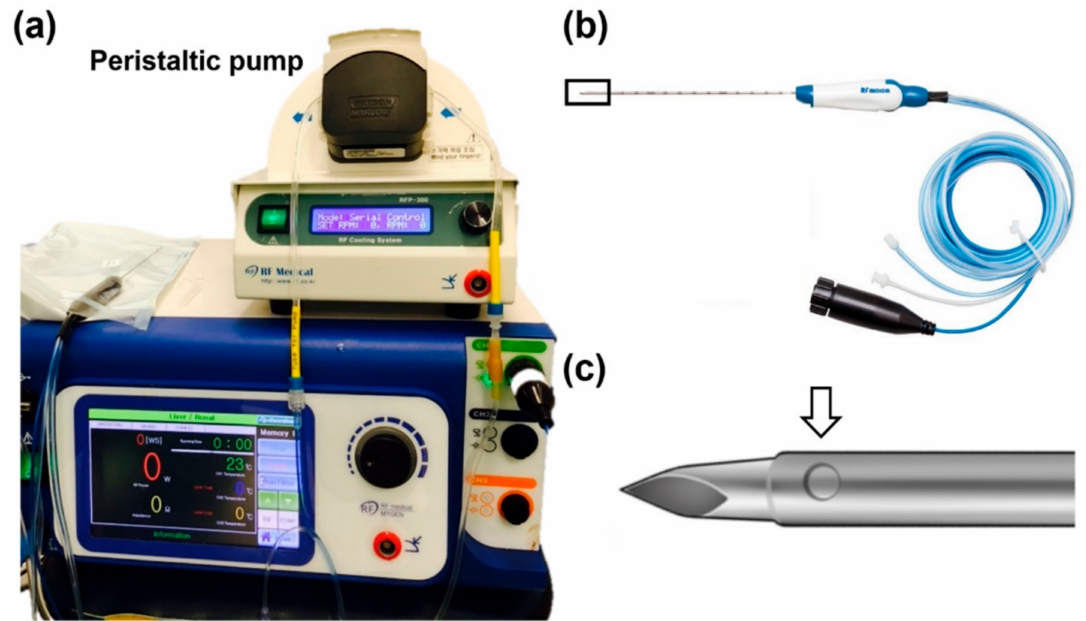
Figure 2. The radiofrequency ablation (RFA) system configuration. ( a ) A three-channel radiofrequency ablation system, which can allow the use of multiple electrodes in either monopolar or bipolar modes. ( b ) An internally cooled wet electrode with a 2-cm active tip. ( c ) The magnified image of the DRCWE tip with a side hole (white